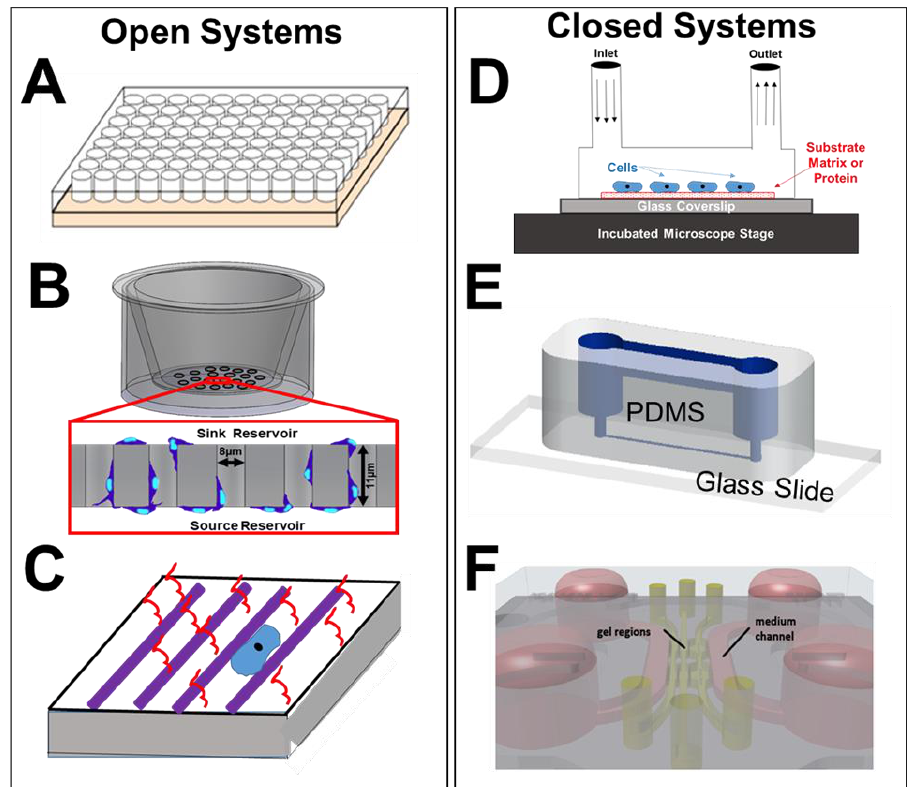
Figure 5. Description of prevalent microscale assays (open and closed) applied in biomedical studies and cell-based analyses of the retina. ( A ) A schematic of a multi-well substrate (hundreds to thousands of parallel wells) used for culture of individual cells or groups, as well as for study of cellular responses to extracellular solutions and matrix proteins. ( B ) Schematic of transwell assay (e.g., Boyden Chamber) where cells are inserted into a top, or sink, reservoir and migrate within the pores of a semi-permeable membrane towards the bottom, or source, reservoir. Motile cells then adhere to the underside of the membrane, are stained, and counted to estimate numbers of motile cells (reproduced with permission from [189]). ( C ) Rendering of a micro-patterned substrate, comprised of a flexible (or rigid) substrate that is functionalized with a densely-packed array of polymer substances in a pre-designed arrangement. Substances are additionally conjugated with proteins of interest for cellular interactions significant to guidance of cell processes or extensions, and cell culture when immersed in medium. ( D ) Schematic of a simplified micro-perfusion chamber, where cells are immobilized upon a coated glass side (or coverslip) and exposed to continuous flow via inlet and outlet ports. The chamber is placed within an incubated microscope stage for real-time observation of cell culture, growth, and alignment under flow conditions. ( E ) Schematic of microfluidic channel flow systems (reproduced with permission from [190]), where flexible substrates of PDMS or PMMA are bonded onto microscope slides (or coverslips) to control properties of the interstitial environment and facilitate visualization of cell behaviors. ( F ) Rendering of an on-a-chip device containing multiple, interconnecting layers of cells (reproduced with permission from [186]). and flows to facilitate 3D modeling and organoid models, also known as micro-physiological systems. Two parallel culture chambers on the chip are separated by a central channel containing a pillared array of structures at both sides of the channel for interconnection (reproduced with permission from